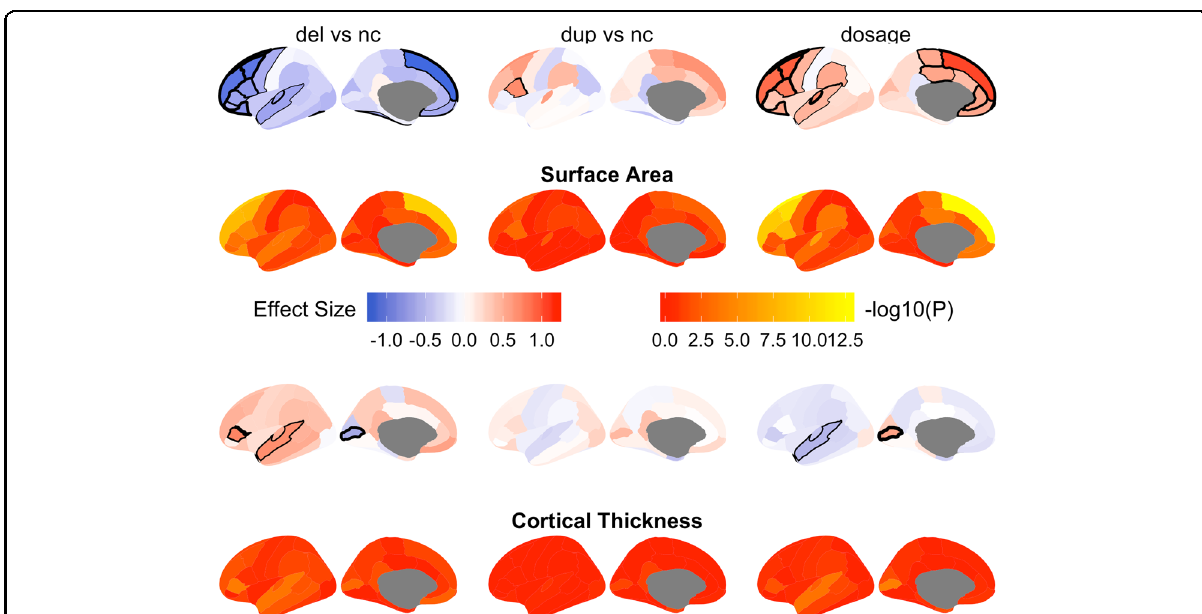
Fig. 2 Results from the t tests and linear regression of 1q21.1 copy number variation on regional cortical surface area and cortical thickness. First and third rows: Effect sizes (Cohen ’ s d for the t tests, beta coef fi cient for the dosage/linear regression). Second and fourth rows: Statistical signi fi cance in – log 10 of the P value. Signi fi cant areas in rows 1 and 3 are marked with black lines with increasing thickness for increasing signi fi cance ( P < 0.0014). The column names indicate the comparisons with del = deletion carriers, nc = non-carriers, dup = duplication carriers. All measures were corrected for age, age 2 , sex, scanner site and